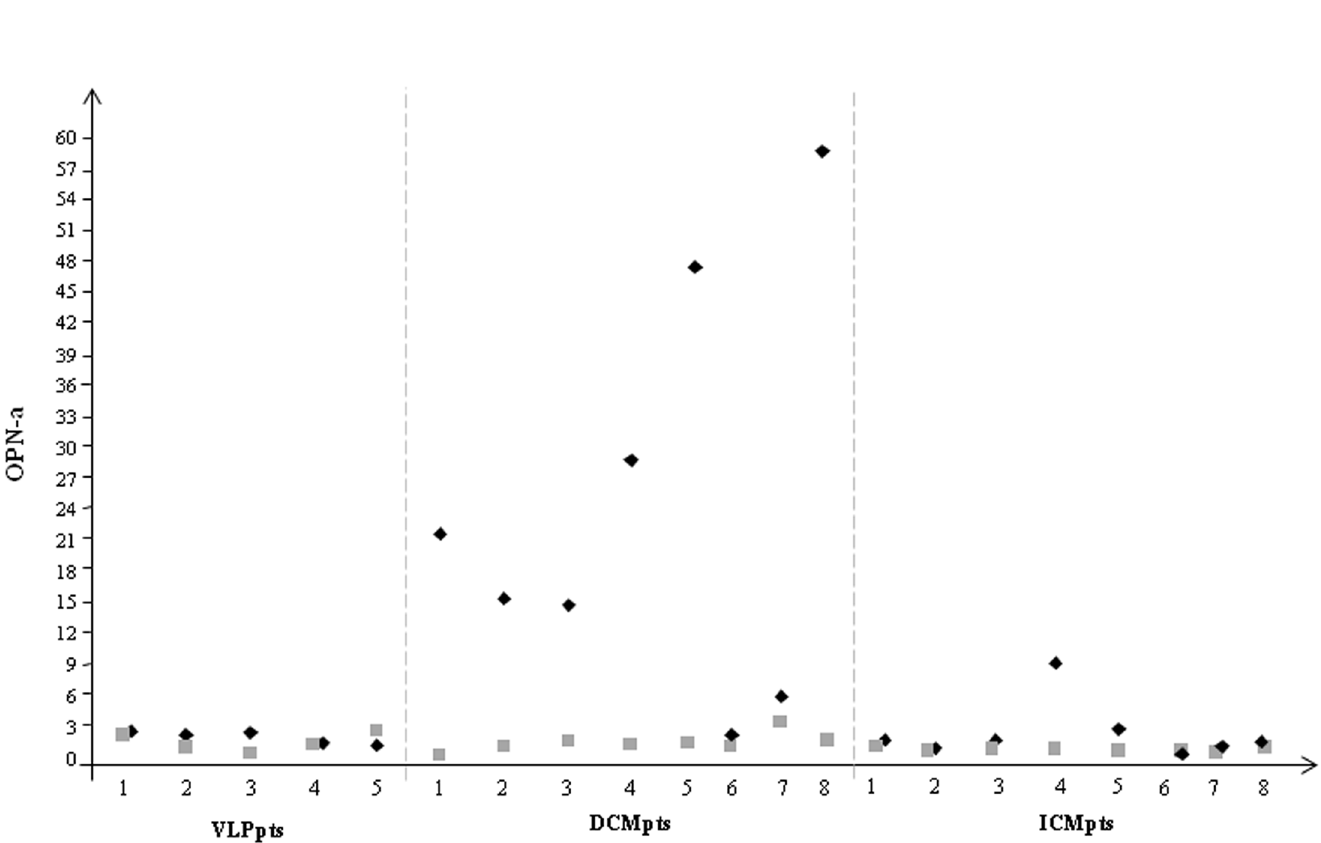
Fig 5. Comparison of OPN-a at protein and at mRNA level. Individual data plot of mRNA expression and protein concentration for VLP, DCM and ICM groups (Black rhombus:mRNA espression, grey square:protein concentration, ng/ml).